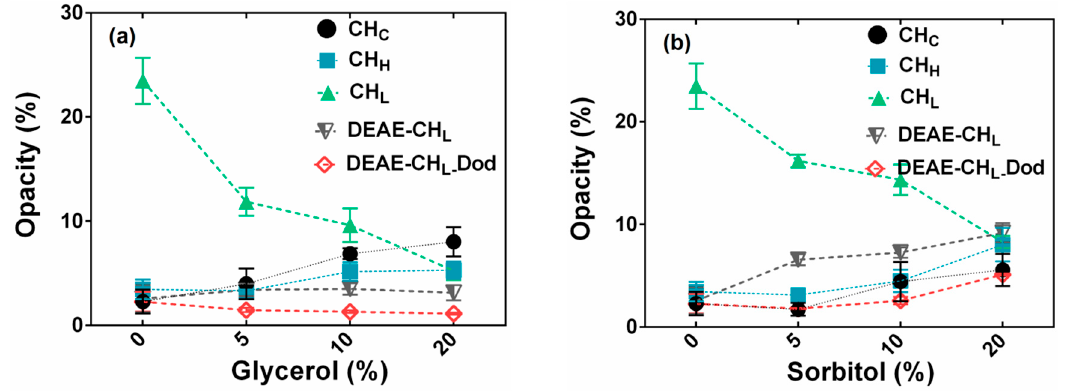
Figure 7. Opacity as a function of (a) glycerol and (b) sorbitol percentages (w/w) for the films prepared with chitosan and its derivatives. with chitosan and its derivatives.